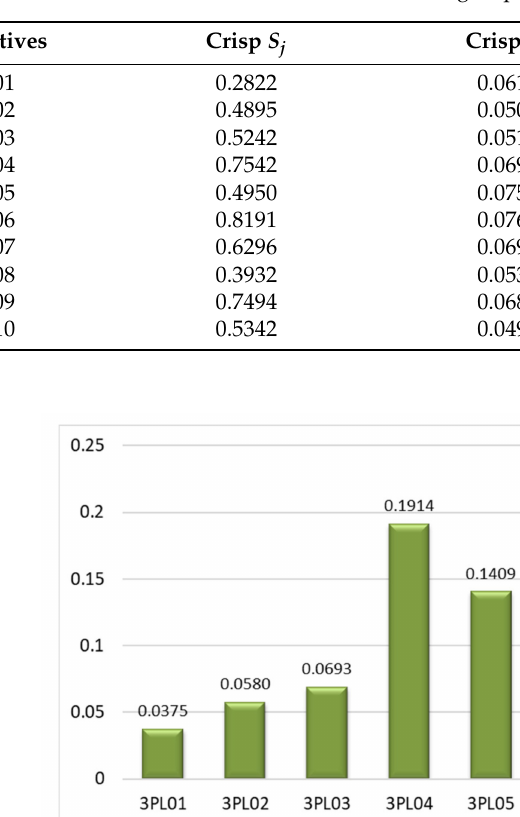
Table 10. The worse group score of FVIKOR model.